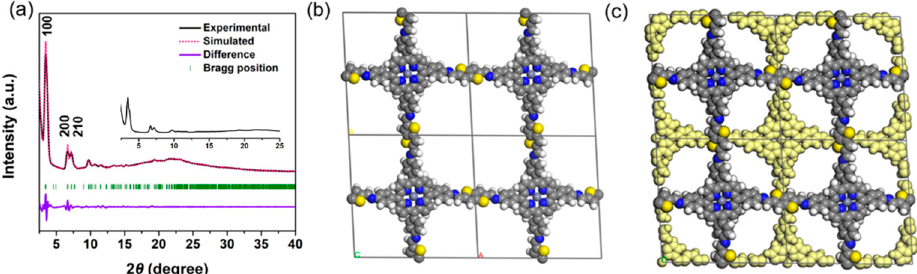
Figure 2. ( a ) Experimental PXRD patterns of Zn-Por-TT COF (black), Pawley refinement (pink), their difference (violet), and Bragg positions (green); ( b ) AA-stacking; and ( c ) AB-stacking models of Zn-Por-TT COF.